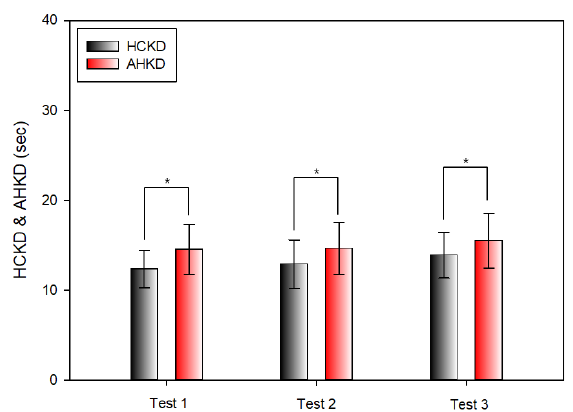
Figure 9. Comparison between HCKD and AHKD(*:p < 0.05) Figure 10. Comparison between VHKD and AHKD(*: p <